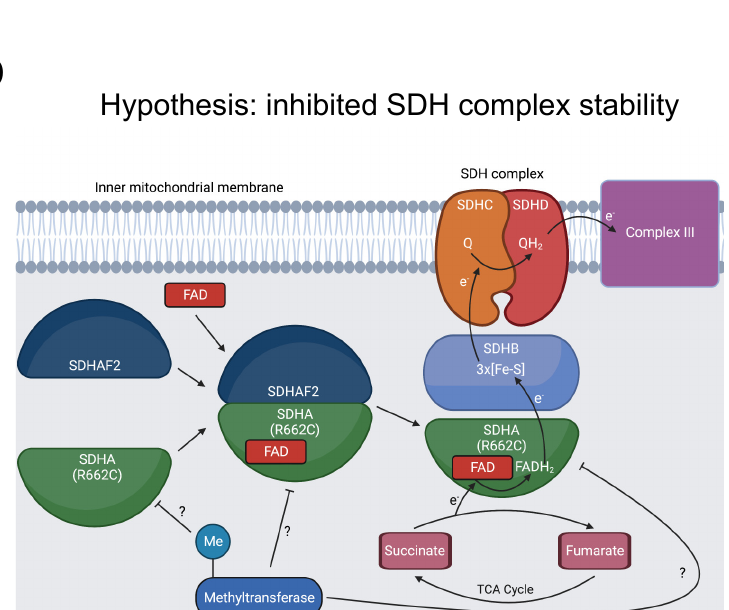
for MCIID and was additionally present in a patient with a paraganglioma